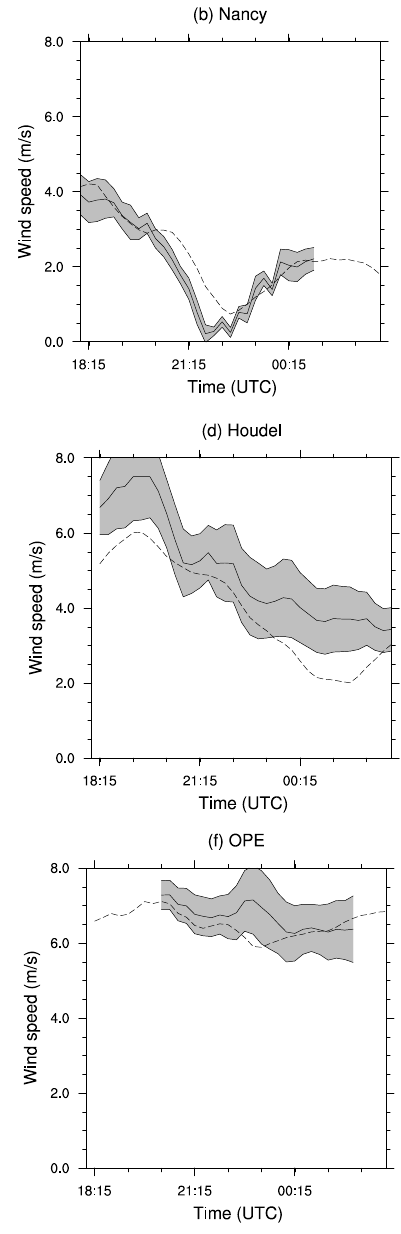
Figure 7. Time series of modelled wind speed at 10m m (left panel: a , c , e ) and at 50 m (right panel: b , d , f ) for Nancy, Houdel, and OPE. The grid point value for the observed sites is represented by the dashed line for M500m and by solid line for M50m. The standard deviations at 500 m horizontal scale are indicated by the grey Figure 8. Same as Figure7 for the modelled wind speed at 10 m (left panel) and at 50 m (right panel).